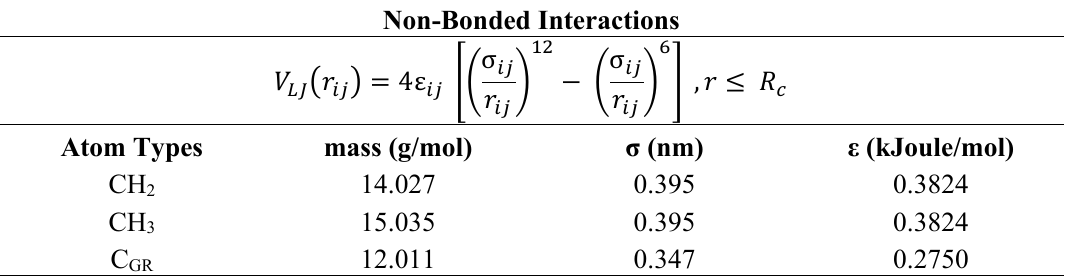
Table A1. Model parameters and functional forms of all non-bonded interactions of the atomistic force field used